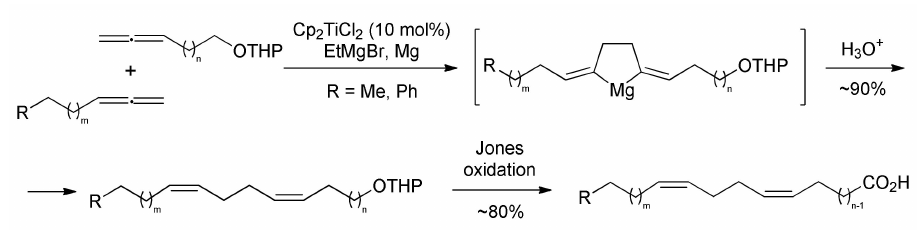
Figure 1. Stereoselective synthesis of dienoic